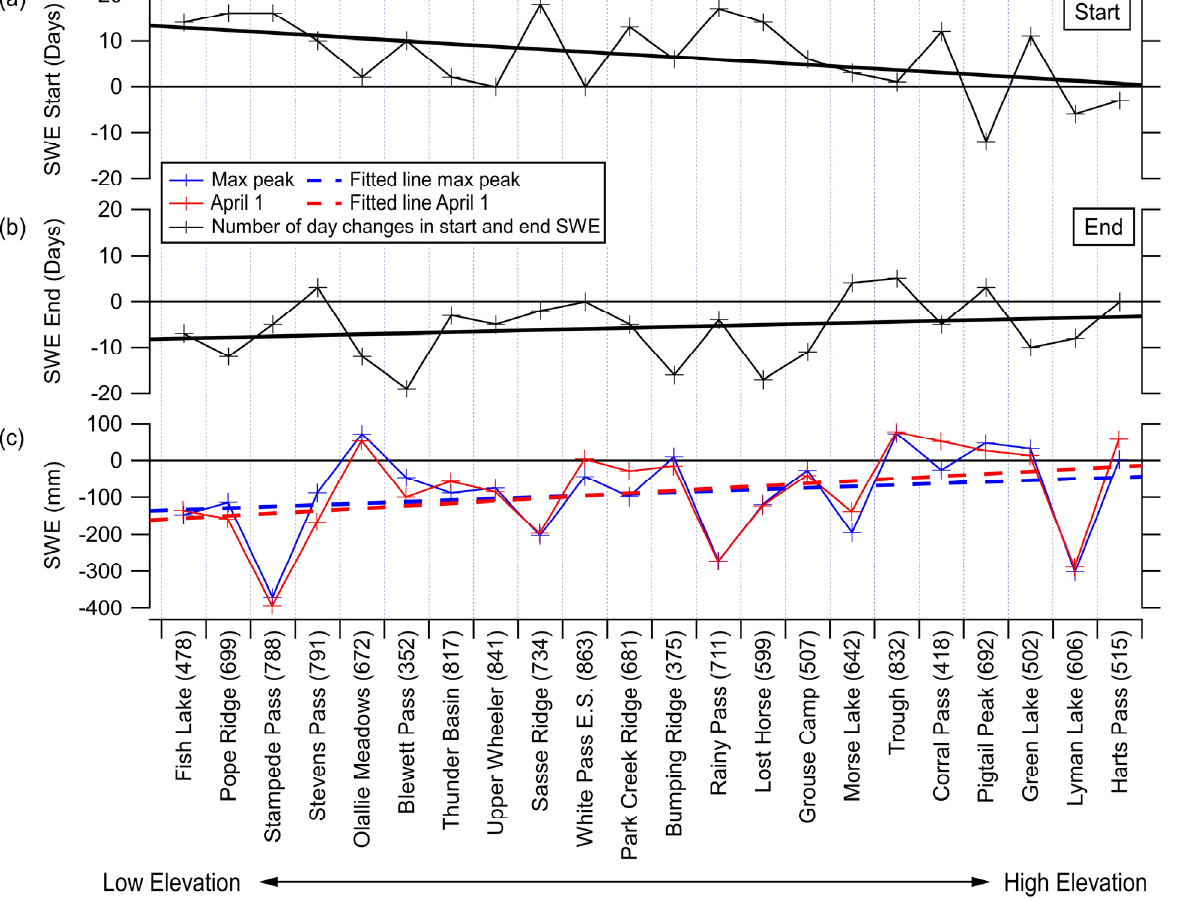
Figure 4. Trends in SWE start where a positive number indicates a later start date ( a ), and trends in SWE end where a negative number indicates an earlier end date ( b ); change in SWE for WY1991–WY2020 ( c ).